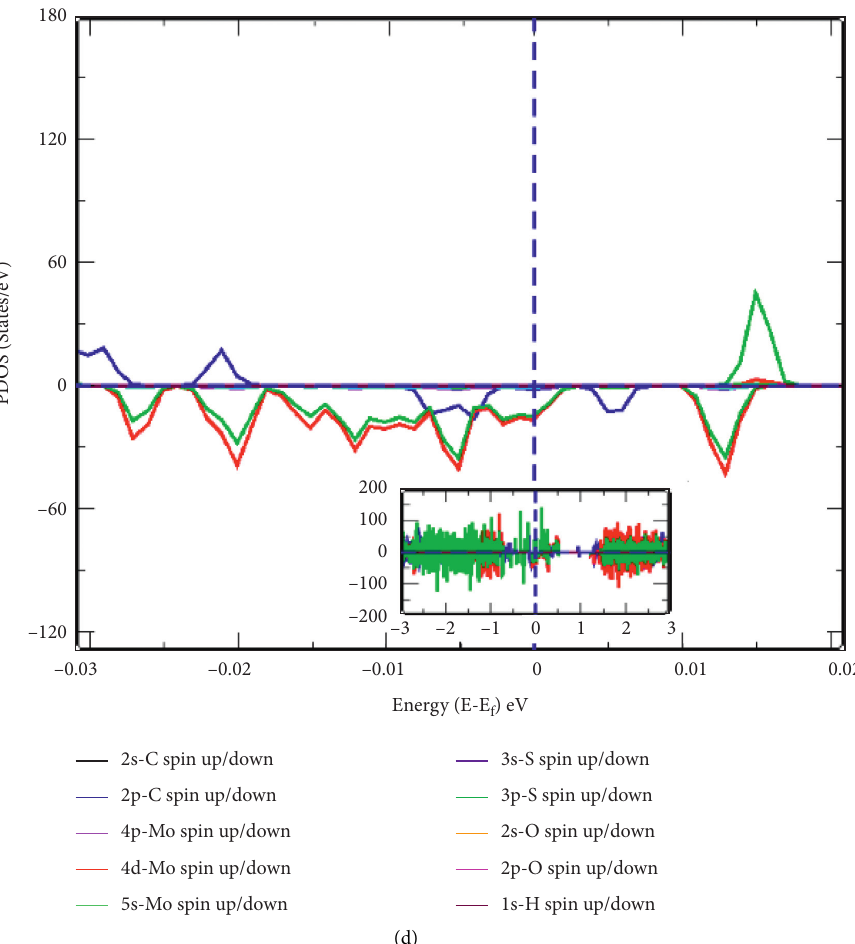
Figure 5: (a) Band structure of system-IIb, (b) DOS of up-spin and down-spin states of electrons in the orbitals of C Mo, S O, and H atoms of system-IIb, (c) PDOS of total up-spin and total down-spin states of electrons in the orbitals of C Mo, S O, and H atoms of system-IIb, (d) PDOS of individual up-spin and down-spin states of electrons in the orbitals of C Mo, S O, and H atoms of system-IIb. In all DOS and PDOS, the horizontal dot line separates spin states and the vertical dot line separates the electronic bands, and also in the band plot, the horizontal dot line represents Fermi energy level. Insets in DOS and PDOS represent the spin states within a large energy range along x